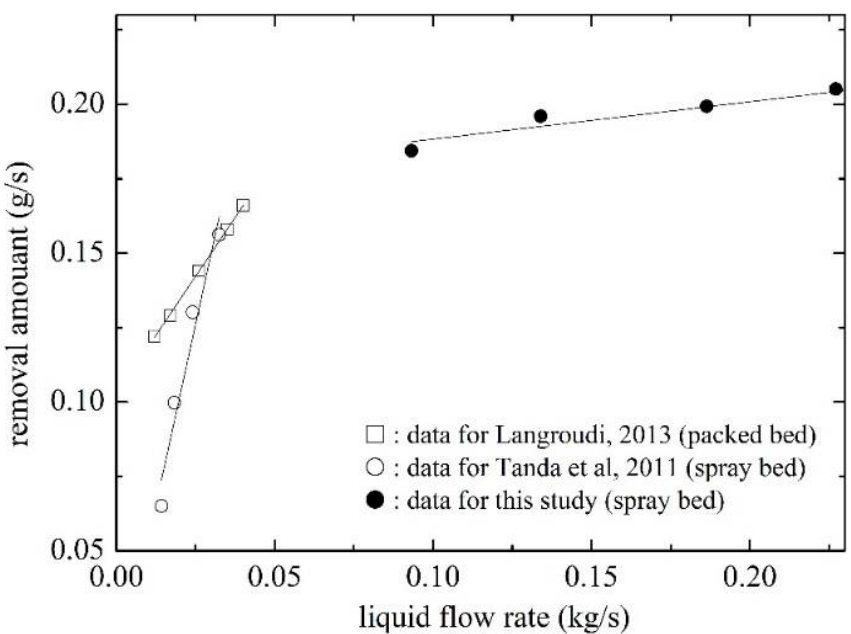
Figure 4. Removal amount compared with literature data.